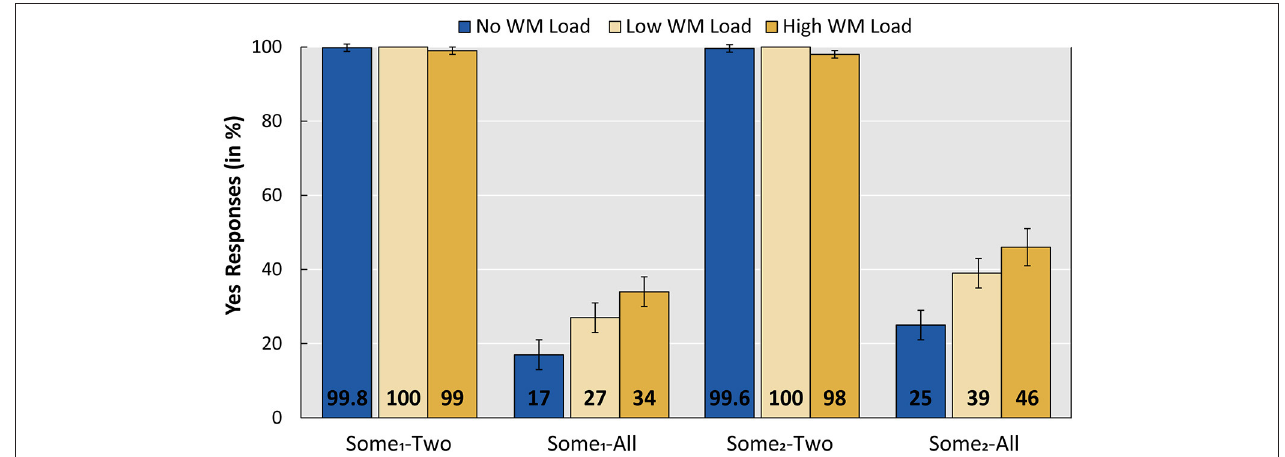
FIGURE 4 | Mean acceptance rates per implicature control condition per WM load (No load, Low, High). Error bars show standard error. The WM Load group was tested with Low and High WM load; the No WM load group was tested on the linguistic task only. Sentences contained either sommige “some1” or enkele “some2,” and pictures showed either two out of three actors or all three actors performing the action denoted by the sentence.